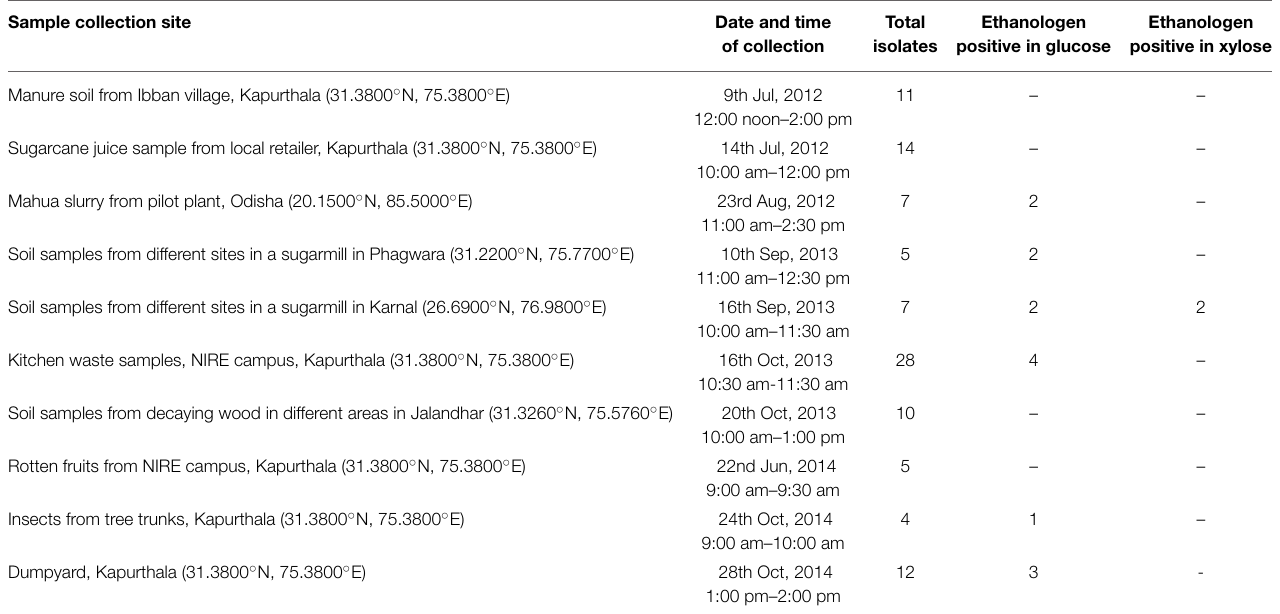
TABLE 1 | Microorganisms isolated from various sites for bioethanol production.